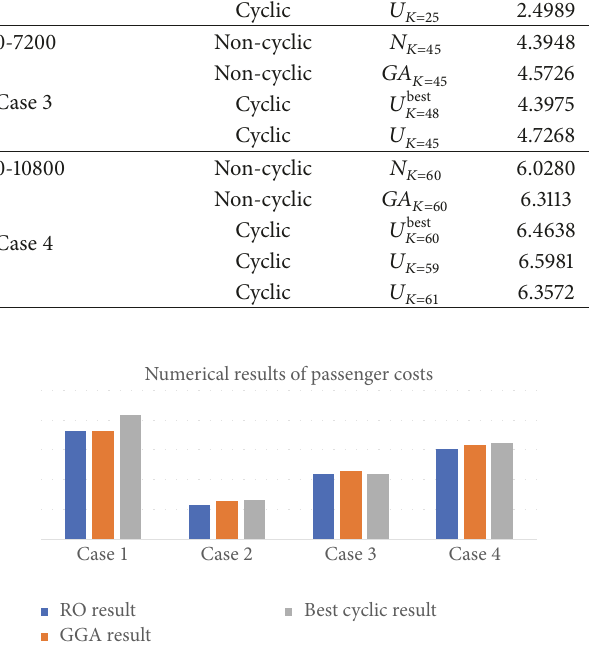
Figure 7: Passenger costs for different results in different